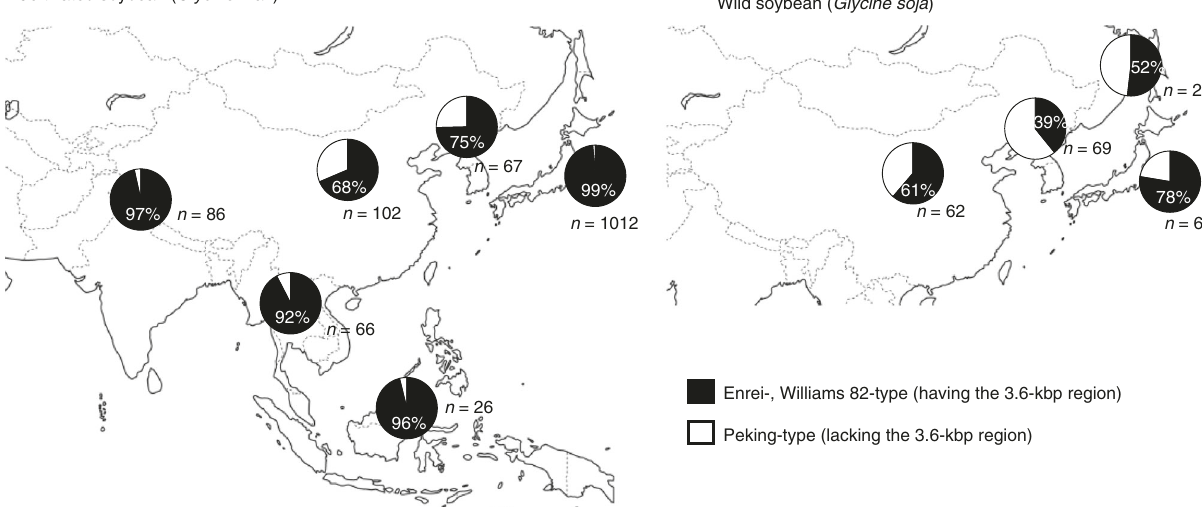
Fig. 3 Geographical distribution of genetic diversity of the Rsv4 locus. The presence or absence of the 3.6-kbp region in Rsv4 in cultivated soybean ( Glycine max ) and wild soybean ( G. soja ) are shown in black or white, respectively. The number of investigated plants and percentage of plants having the 3.6-kbp region are indicated for each geographical area. See also Supplementary Data